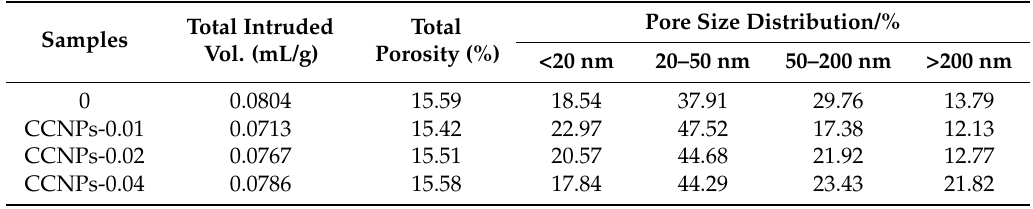
Table 2. Porosity and pore size distribution of different